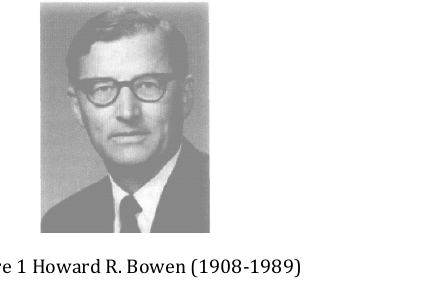
Figure 1 Howard R. Bowen (1908-1989)